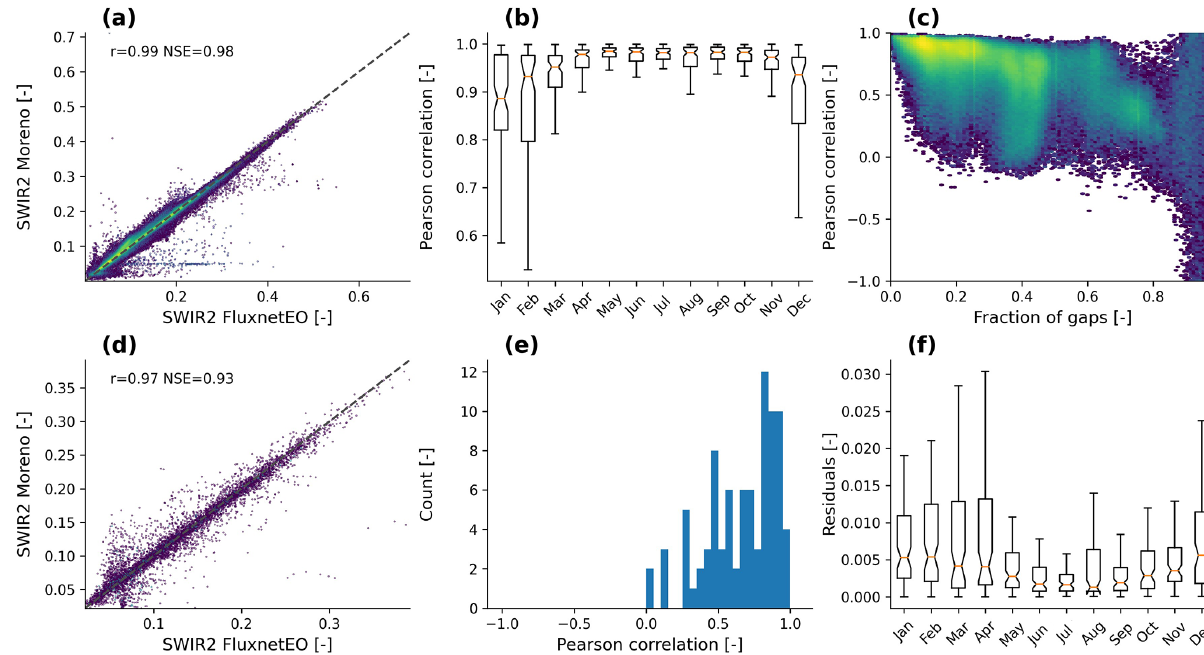
Figure C7. Same as Fig. C3 but for the second shortwave infrared spectral band.